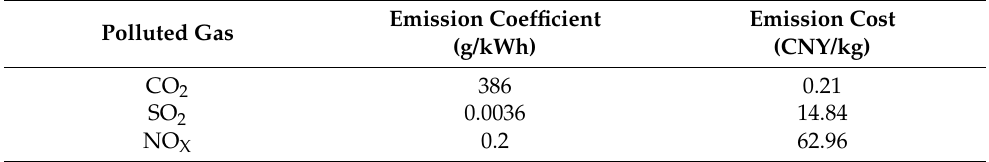
Table 3. The parameters of the equipment in CCHP System.